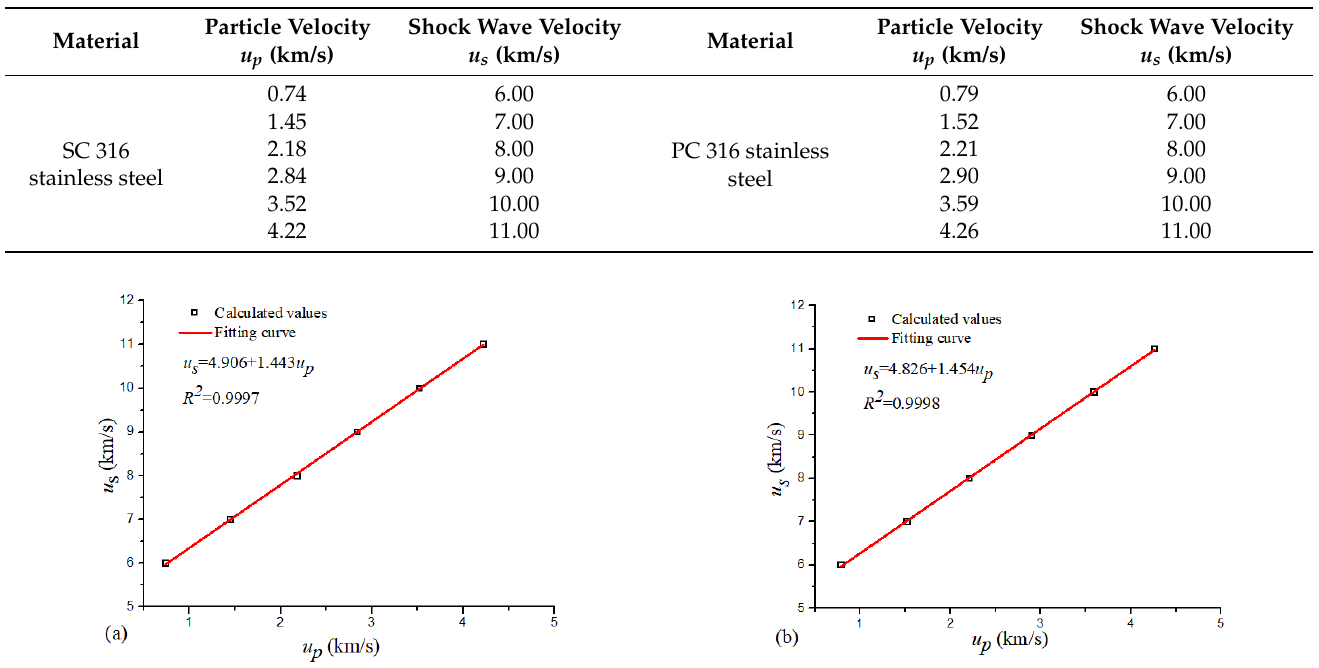
Table 1. Hugoniot data of 316 stainless steel at 300 K.